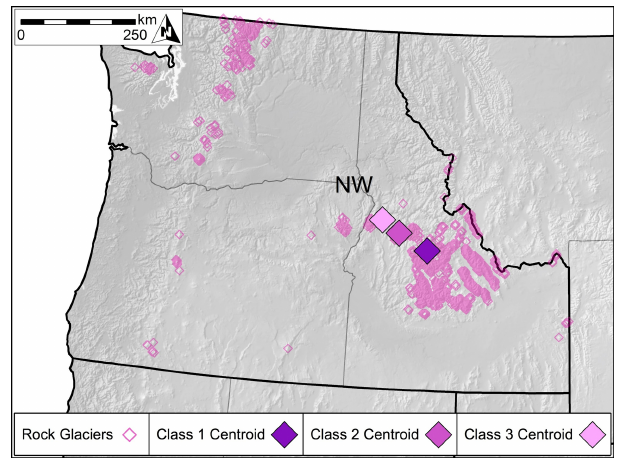
Figure 6. Locations of NW Region rock glacier inventory features ( n = 1993), as well as centroids for Class 1 ( n = 1293), Class 2 ( n = 512), and Class 3 ( n = 188) features. Rock glaciers of the NW Region are largest and most densely concentrated in the Sawtooth Mountains of Idaho.